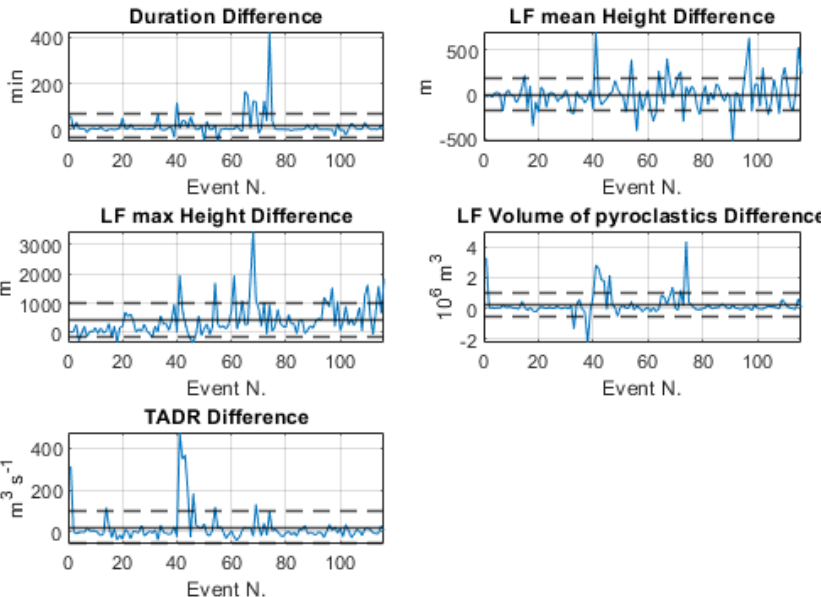
Figure 2. Differences in duration, mean and maximum LF altitude, volume of pyroclastic material and TADR for each episode obtained by the manual and automated procedures. The solid horizontal lines in black represent the mean error, whereas the dashed horizontal lines indicate the standard deviation error. Table 1. Numerical values for the mean difference and the standard deviation comparing the man- ual and automated procedures of pyroclastic material volume calculation.